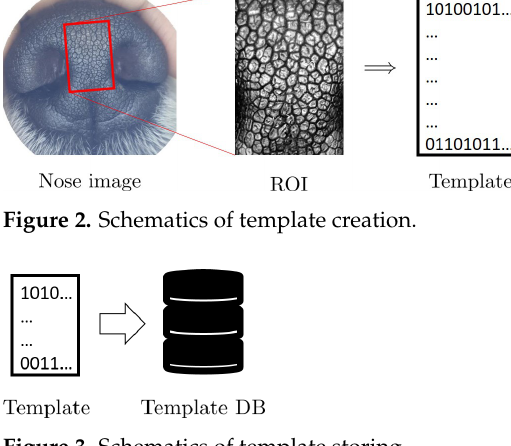
Figure 3. Schematics of template storing.